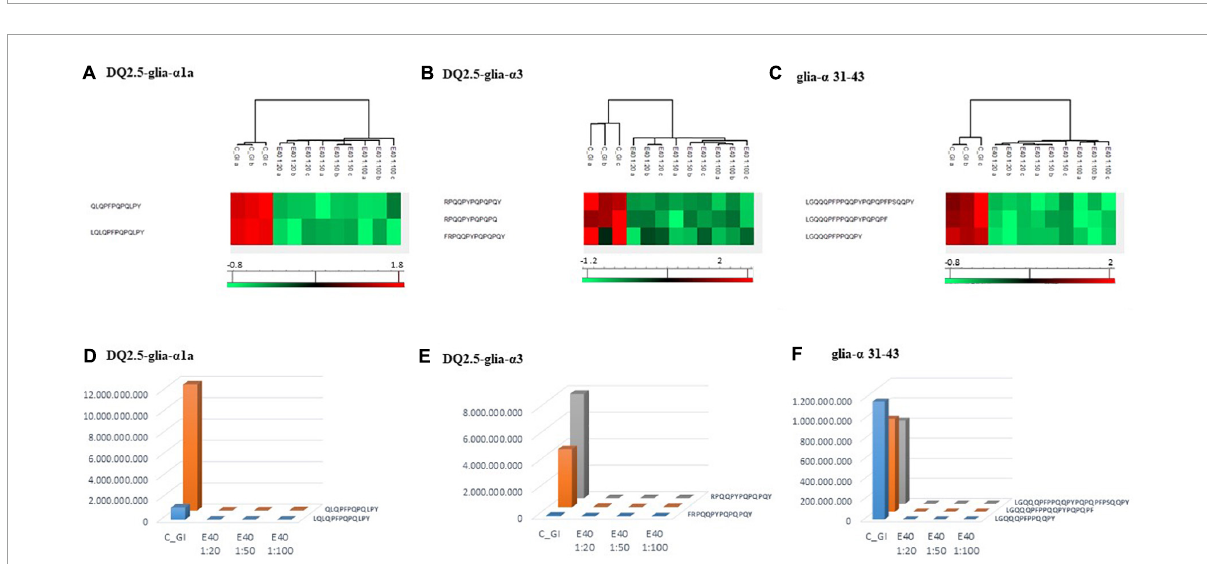
FIGURE6 Residual intestinal immunogenic α -gliadin sequences in pasta control (GI) and digesta at dose-dependent E40 detoxification (1:20, 1:50, and 1:100). ( A–C) Heatmap of LC-MS/MS analysis of the proteases resistant peptides harboring α -gliadin CeD epitopes, of the technical replicates of Control (GI) and E40 glutenase groups; the red color represents high-resistant, and the green color represents low-resistant gluten peptides; values are scaled across columns, generating column z-scores. (D–F) Graphical representation of the sum (average value of technical triplicates) of LC-MS/MS intensity of peptides harboring CeD α -gliadin epitopes identified in control (GI) and E40 (1:20, 1:50, and 1:100) treated pasta sample.